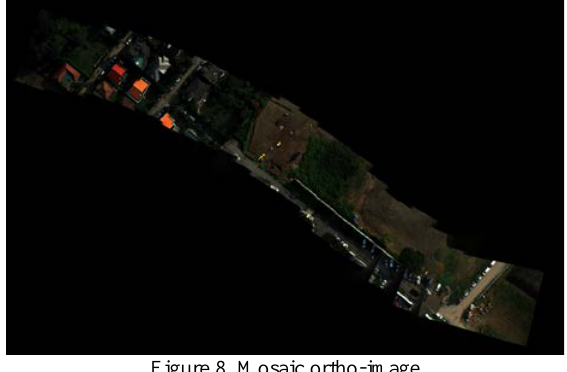
Figure 8. Mosaic ortho-image